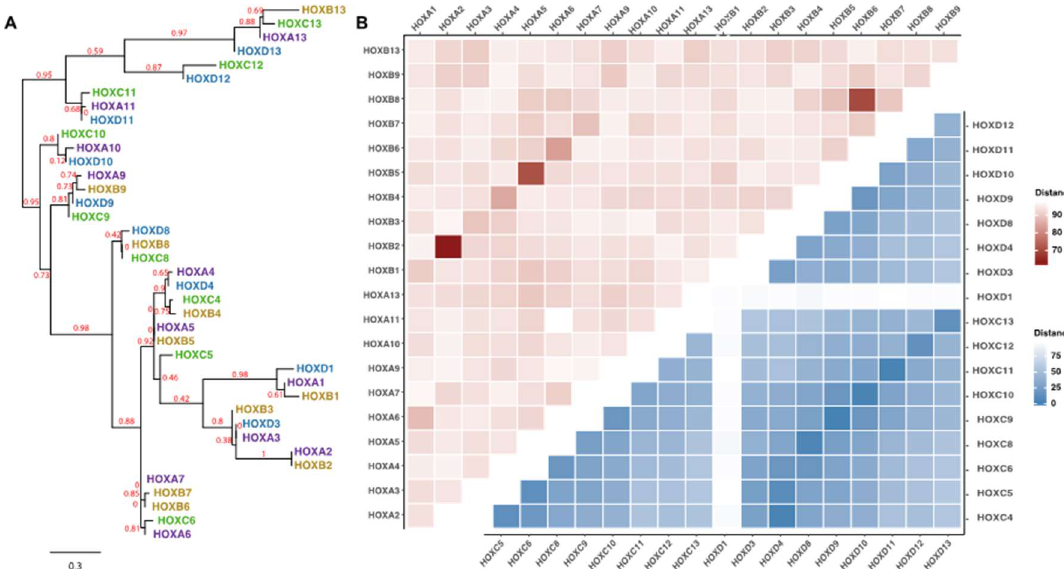
Figure 2. Phylogenetic analysis of HOX genes. ( A ) Shown is a phylogram using the full-length protein sequences of the HOX family members generated by phlogeny.pr [9,10]. The bootstrap value, representing the reproducibility of the tree structure, is shown for the horizontal branches; the scale bar indicates the length representing 0.3 substitutions per site. All HOX family members from a given locus are in the same color. ( B ) Shown is a distance matrix comparing the full-length protein sequences from the HOXA locus to the full-length protein sequences from the HOXB locus (left top triangle; pink squares) and a distance matrix comparing the homeodomain sequences of the HOXC proteins versus the homeodomain sequences of the HOXD proteins (right bottom triangle; blue squares); matrices were created using distmat [11]. Color legend: Distance: the darker the color, the more similar are the two proteins and the lighter the color the less similar are the two proteins. The HOX sequences were retrieved from RefSeq [12] and the homeodomains were annotated using Pfam [13]. A full distance matrix comparing all 39 HOX proteins (full-length and homeodomains) is shown in Figure S1; see Table S1 for all distance values.